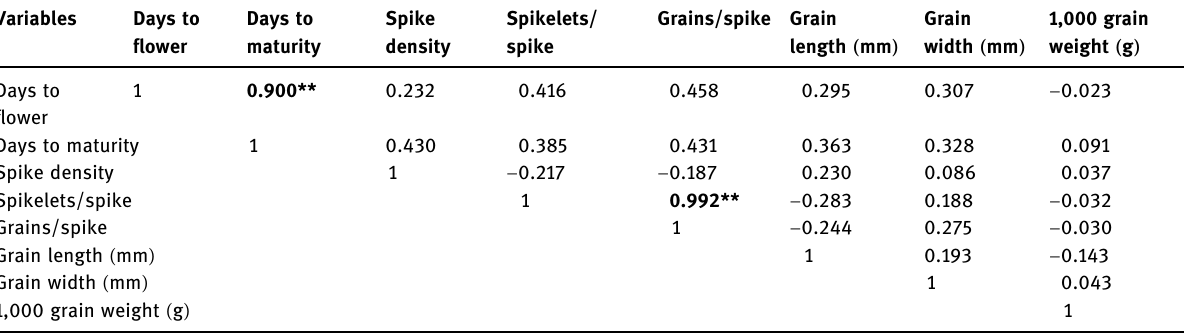
Table 4: Simple correlation coe ffi cients among yield associated characters in indigenous Omani barley germplasm